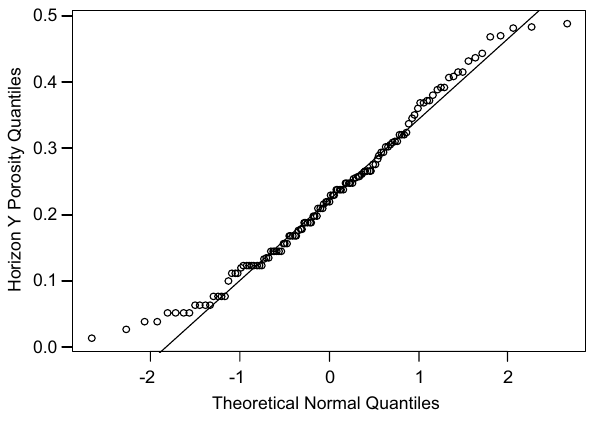
Fig. 12 Normal Quantile–quantile plot of individual porosity val- ues—Horizon Y